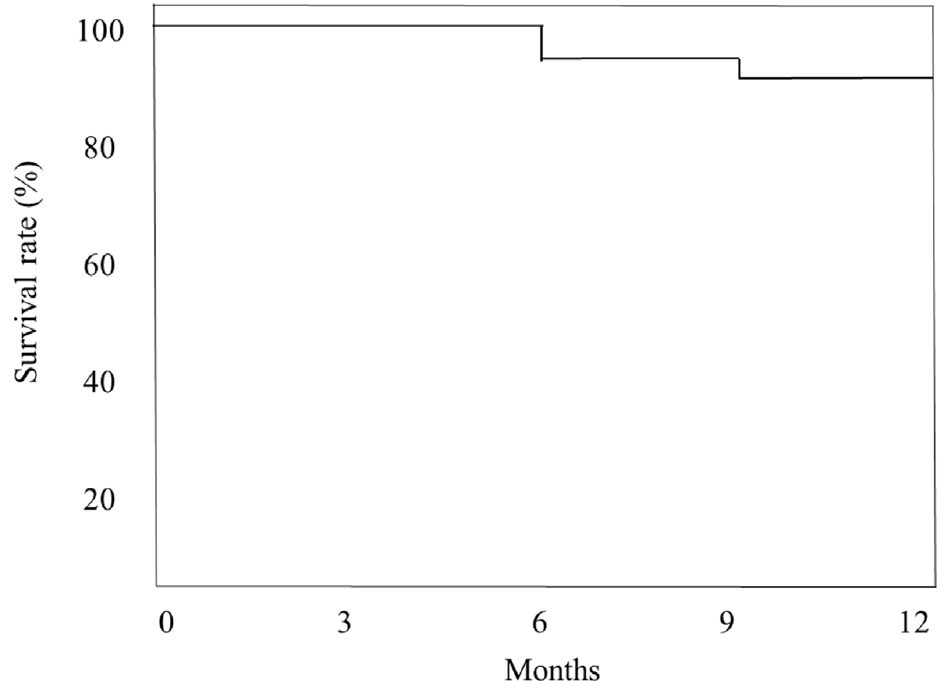
Figure 2. Kaplan–Meier survival curve of the surgical outcome. Table 2 shows the reduction in CECD after surgery. The mean CECD was 2431.4 ± 367.5 cells/mm 2 at preoperative baseline. The reduction rate at 6 and 12 months was 3.69 ± 13.67% and 2.73 ± 9.29%, respectively. The CECD was also measured in the